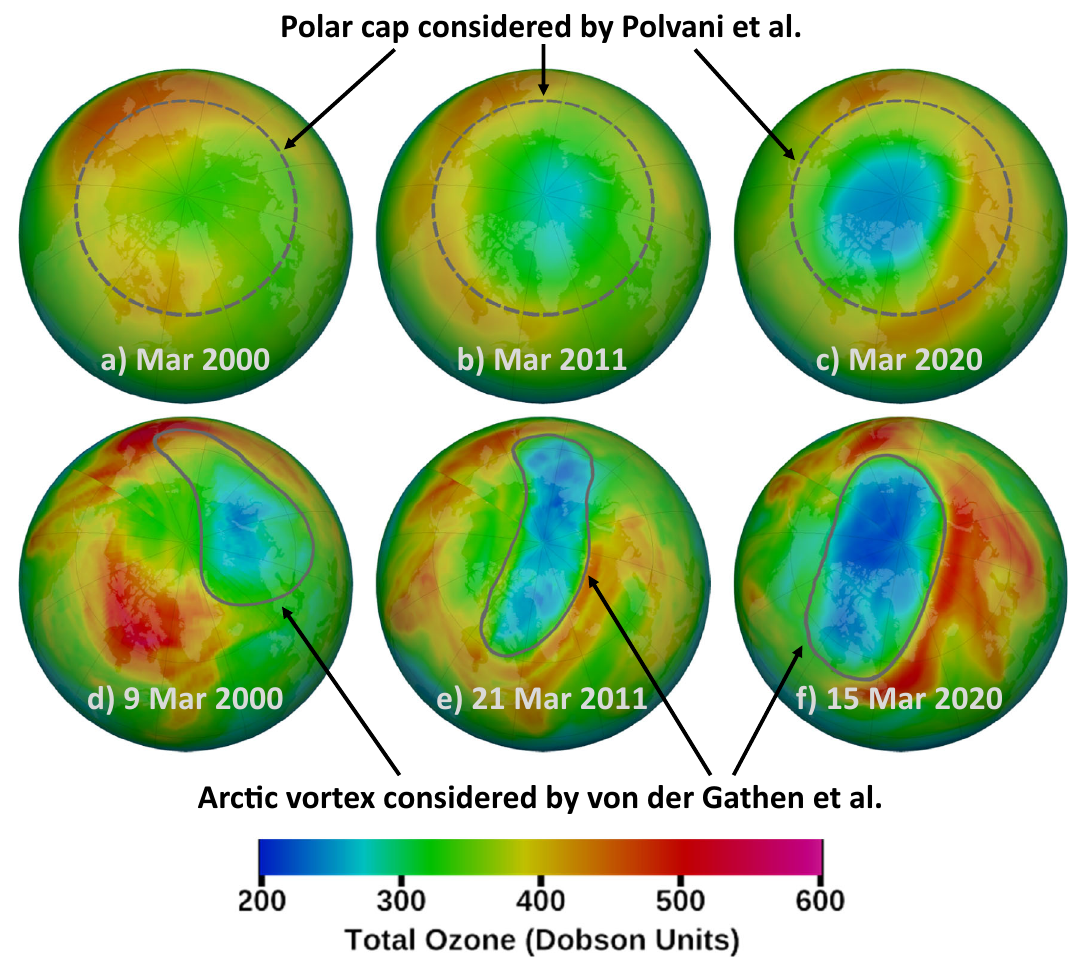
Fig. 1 | Total Column Ozone, Arctic, for selected years. The fi gures on the top (panels a – c ) show the monthly mean total column ozone in DU for the Northern HemisphereinMarch2000,2011,and2020,respectively,asmeasuredbytheTotal Ozone Mapping Spectrometer-Earth Probe (TOMS-EP) satellite (2000), the Ozone MonitoringInstrument(OMI)instrumentonboardtheAurasatellite(2011),andthe Ozone Mappingand Pro fi lerSuite(OMPS)instrumentonboardtheSuomiNational Polar-orbiting Partnership (NPP) satellite (2020). Figures on the bottom (panels d – f ) show the daily distribution of totalcolumnozone on9 March 2000, 21 March 2011, and 15 March 2020. Measurement gaps have been fi lled using data assimila- tion by the NationalAeronautics andSpaceAdministration (NASA)Goddard Space